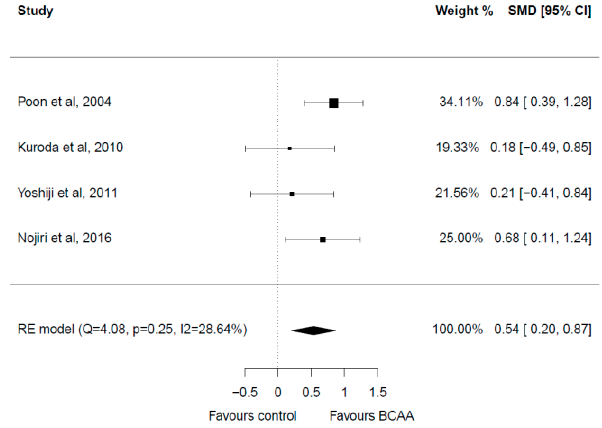
Figure 5. Forest plot for albumin [28,32,33,37].